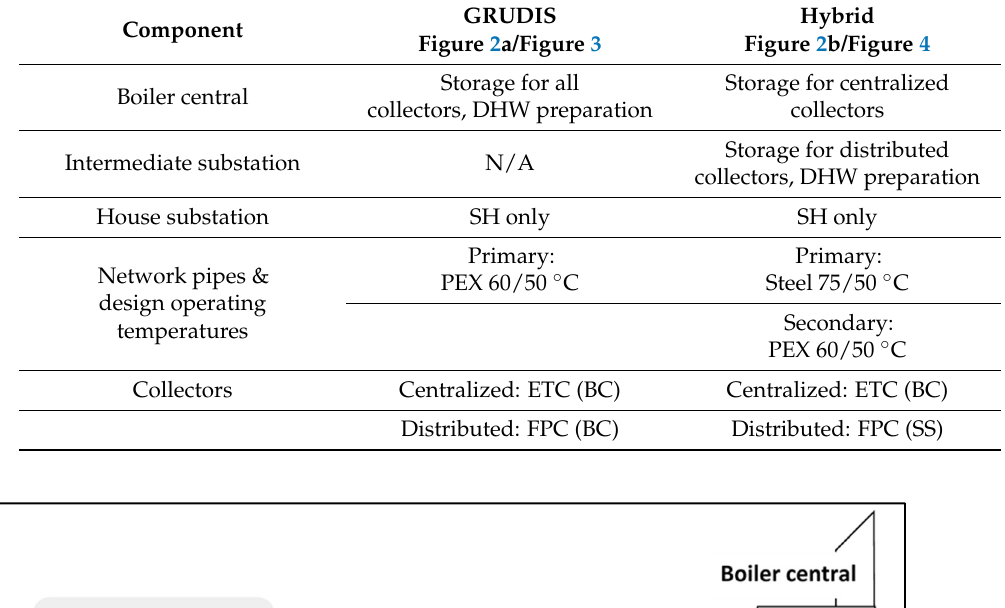
Table 2. Concept overview—summary of the main components of the two distribution concepts studied, along with reference to the figure (s) showing the associated schematic(s). Denotation BC or SS indicates where the collectors are connected to storage.